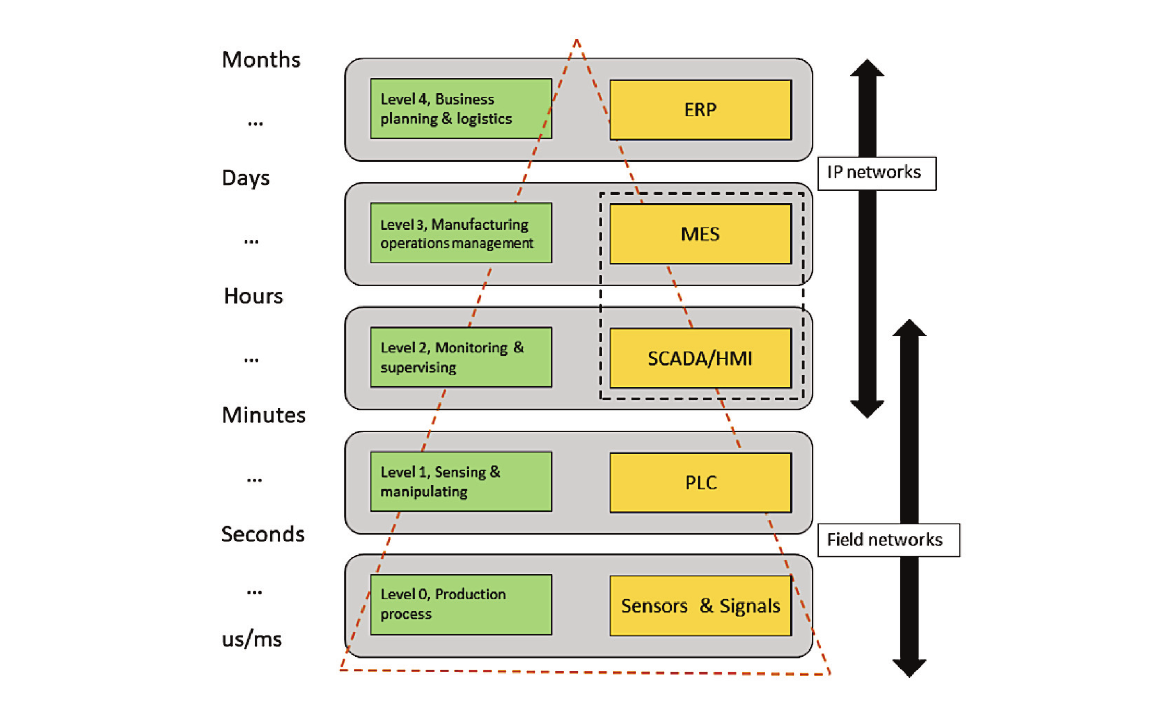
Fig. 3. Integration and connectivity in manufacturing according to ISA-95.00 [6]. SCADA – System Control and Data Acquisition; HMI – Human-Machine Interface; PLC – Product Life